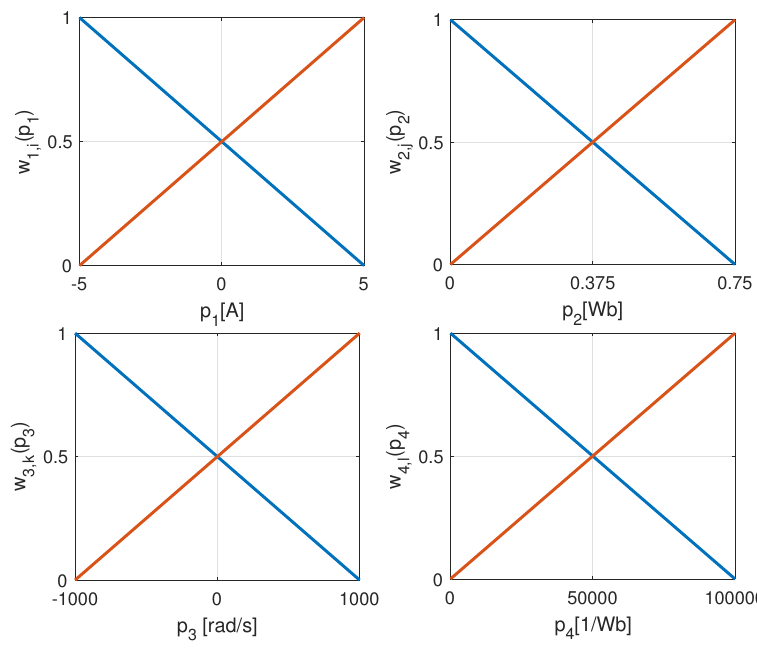
Figure 1. CNO type weighting function of TP